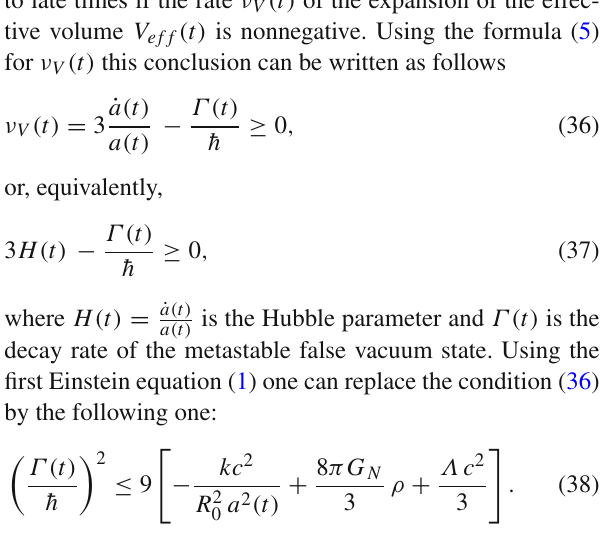
Fig. 7 The modulus of κ(τ) in the logarithmic scale. The case β = 10000. The solid line: | κ(τ) | = | ( E (τ) − E min )/( E 0 − E min ) | ≡ | (Λ( t ) − Λ )/(Λ − Λ ) | . The dashed line: E (τ) = E bare bare 0 const, or, Λ(τ) = Λ 0 = const, ( κ(τ) = 1). The time, t , is measured in lifetimes τ 0 : τ = t /τ 0 and τ 0 = ¯ h /Γ 0 is the